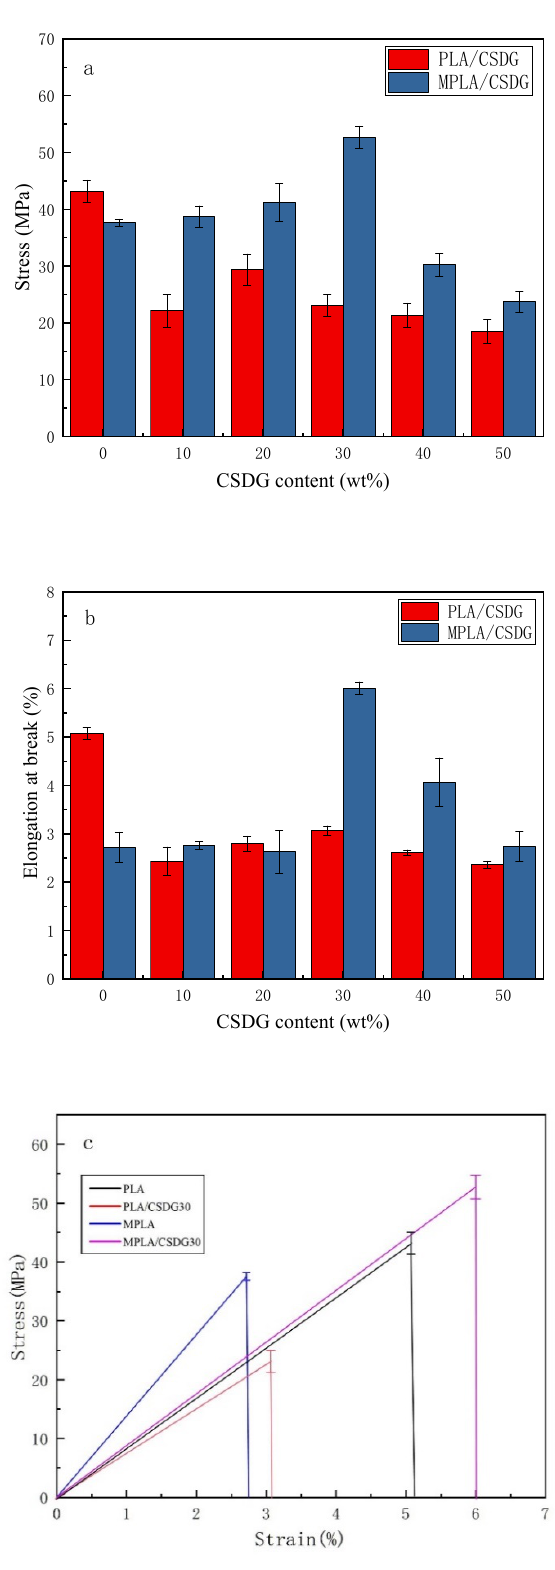
Figure 2. Mechanical properties of PLA/CSDG and MPLA/CSDG composites: ( a ) tensile strength; ( b ) elongation at break; ( c ) stress–strain